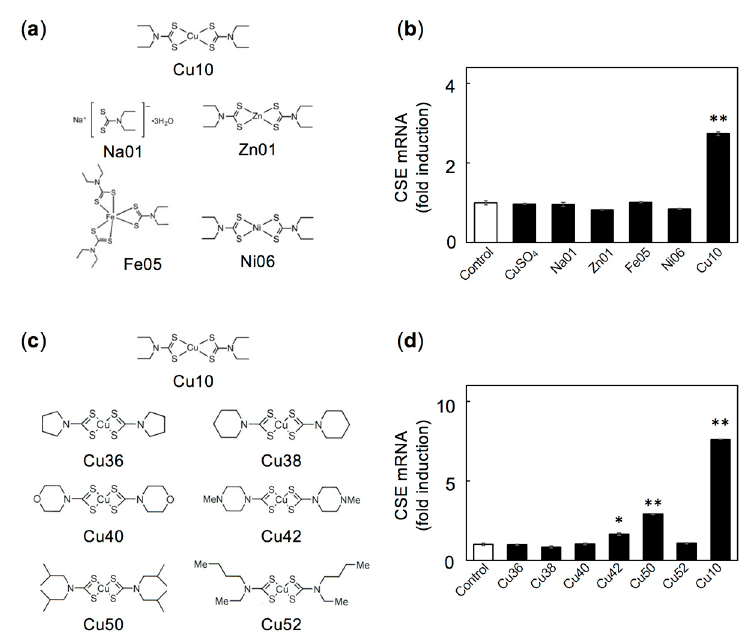
Figure 2. CSE mRNA level in vascular endothelial cells after treatment with Na01, Zn01, Ni06, CuSO 4 , or Cu10 analogs. ( a ) Structures of Cu10, Na01, Zn01, Fe05, and Ni06. ( b ) CSE mRNA level. Dense cultures of bovine aortic endothelial cells were incubated with CuSO 4 , Na01, Zn01, Fe05, Ni06, or Cu10 (5 µM each) for 12 h. Values are mean ± SE of three technical replicates. ** Significant difference from the control, p < 0.01. ( c ) Structure of Cu36, Cu38, Cu40, Cu42, Cu50, and Cu52. ( d ) CSE mRNA level. Dense cultures of bovine aortic endothelial cells were treated with Cu36, Cu38, Cu40, Cu42, Cu50, Cu52, or Cu10 (5 µM each) for 12 h. Values are mean ± SE of three technical replicates. Significant difference from control, * p < 0.05; ** p < 0.01.